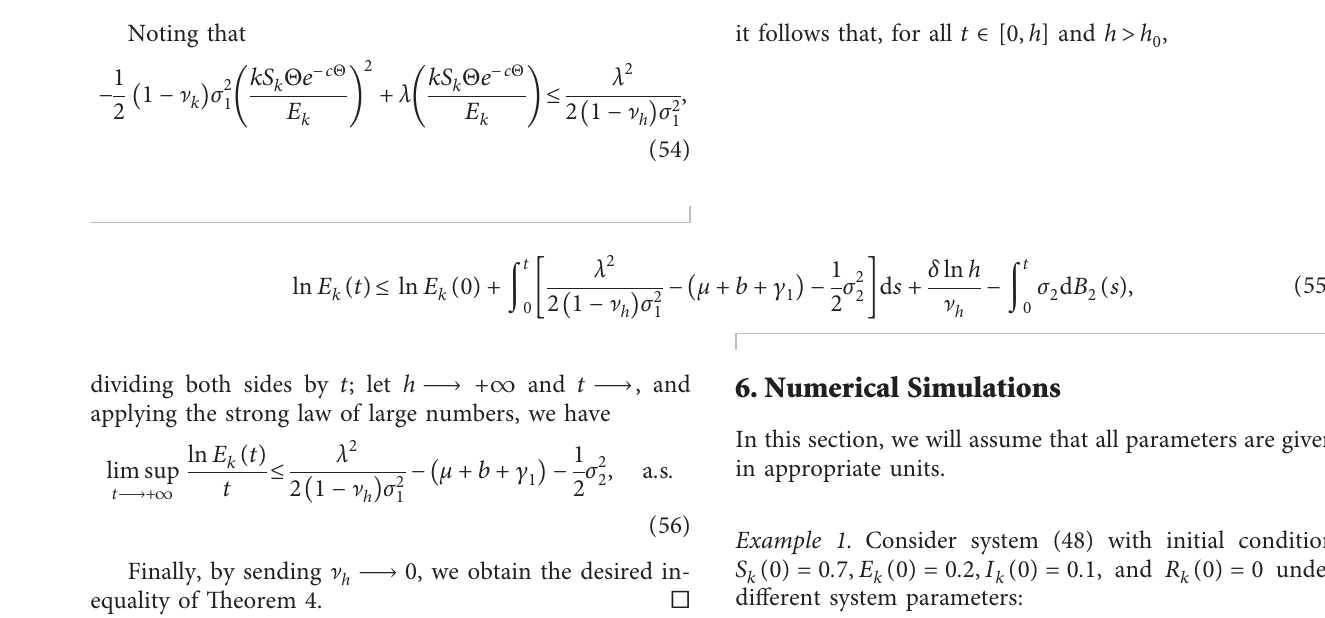
Figure 1: Under the initial conditions given in Example 1, the time evolution of the average density of each state in a complex